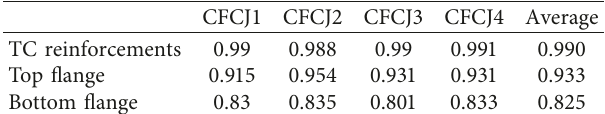
Figure 13: Distribution of longitudinal force along the beam length direction. Table 4: Longitudinal force transferring